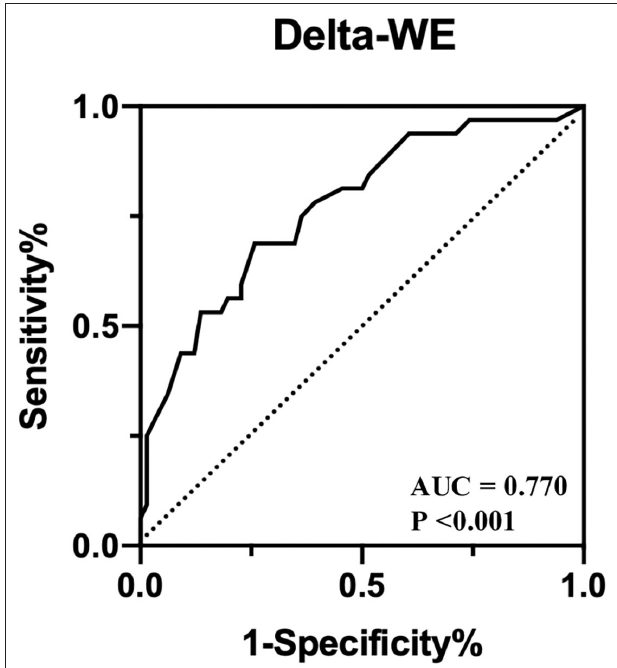
FIGURE 4 | Receiver operating characteristic curves of delta-WE to identify early LV remodeling in anterior STEMI